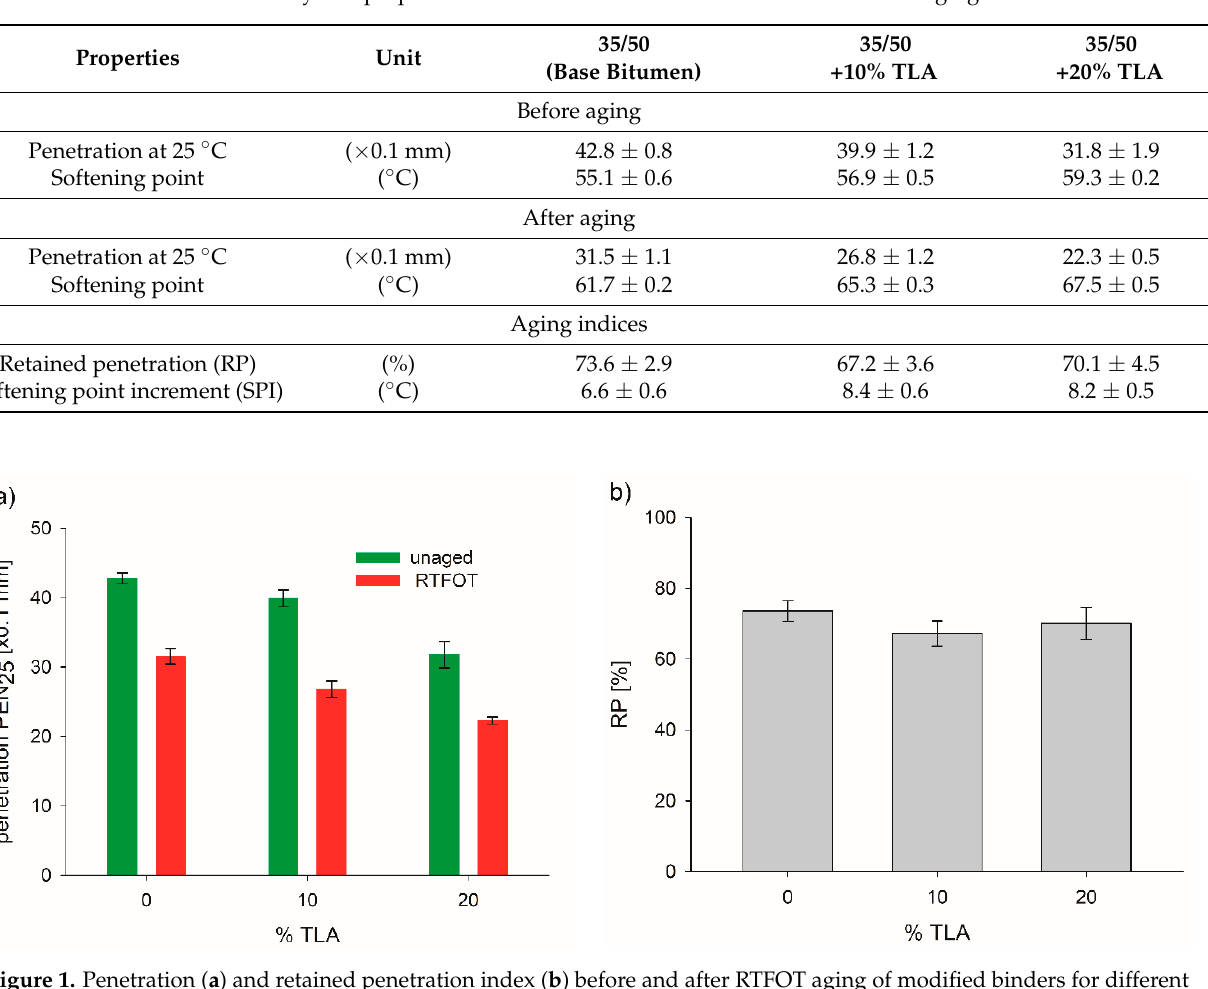
Table 3. Physical properties of the TLA-modified binders before and after aging.